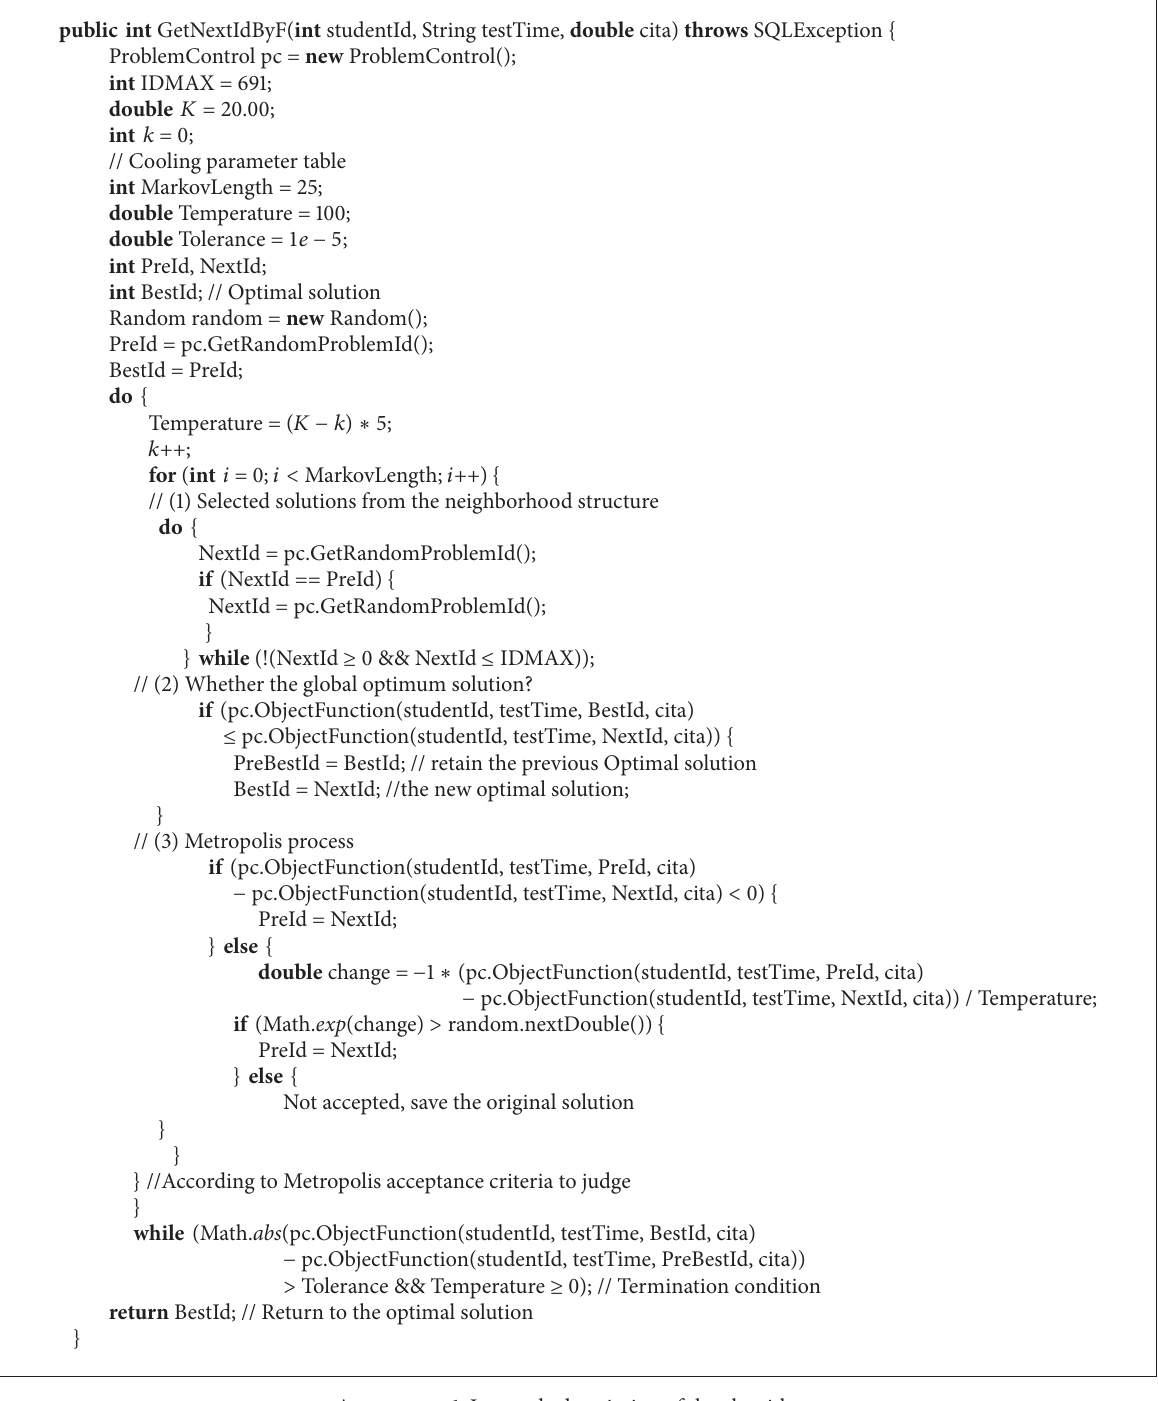
Algorithm 1: Java code description of the